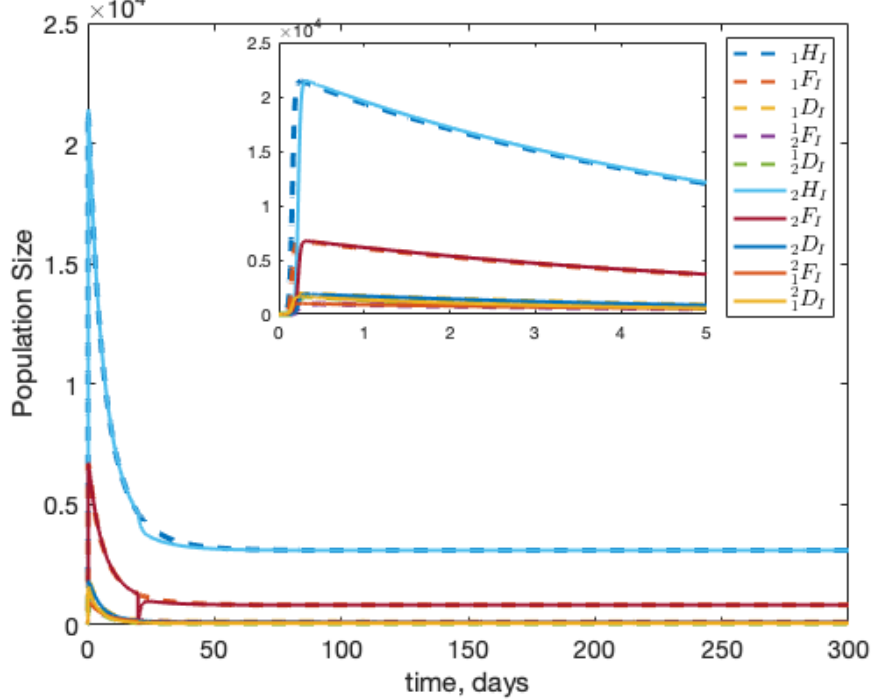
Figure 8. Beginning from equilibrium, we introduce one infected forager into colony 1 ( 1 F I ( 0 ) = 1). In this scenario, we allow drifting between colonies and allow colony 2 to rob colony 1 of resources as the colony begins to die. We see that in this case the effects of robbing are washed